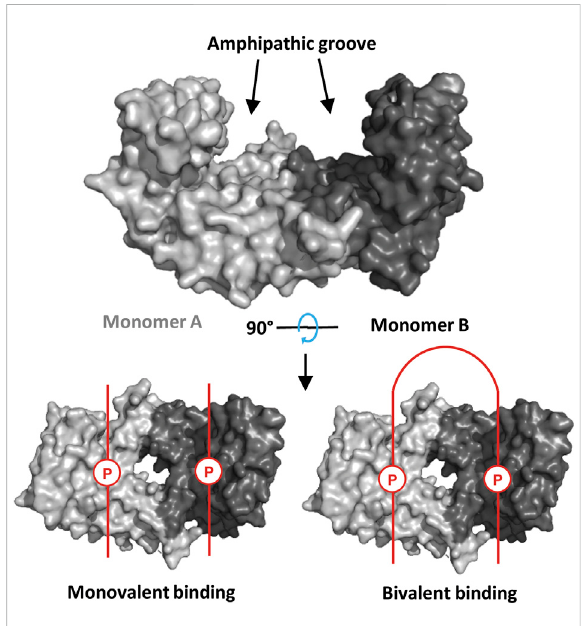
FIGURE 1 Top:Crystalstructureofa14-3-3 σ dimer(PDB:1YWT,partner peptide omitted). Bottom: Partner proteins (phosphorylated bindingmotifsrepresentedinred;P=phosphosite)canbindto14- 3-3 in a monovalent fashion (i.e., 1:1 monomer-partner ratio, left), or a bivalent fashion (i.e., 1:0.5 monomer-partner ratio,